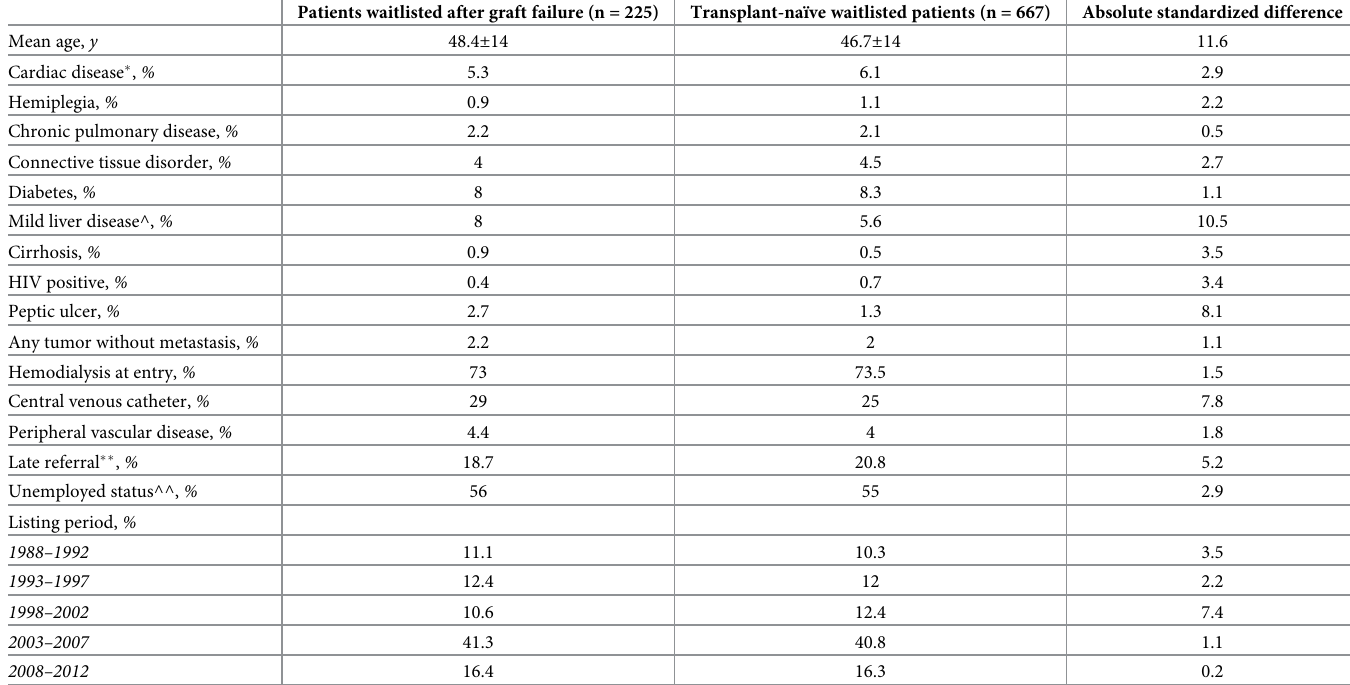
Table 2. Clinical characteristic of patients waitlisted after graft failure versus transplant-na¨ive waitlisted patients after matching 1:5 with replacement. Patients waitlisted after graft failure (n = 225)